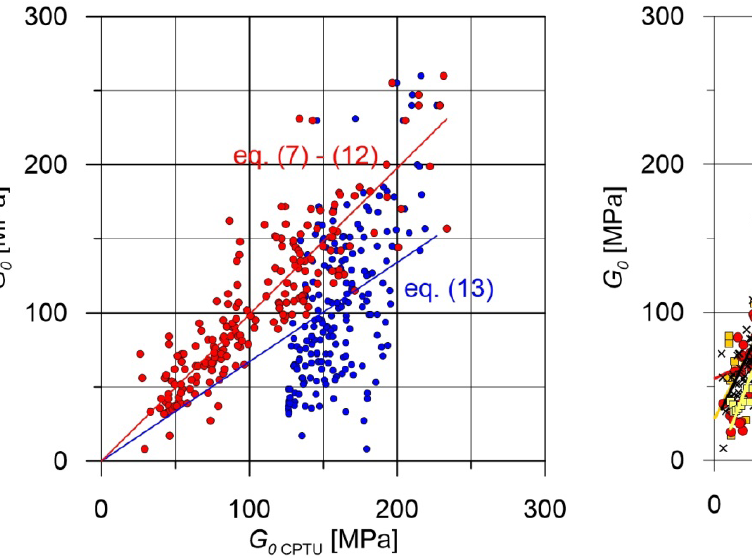
and the preconsolidation Figure 13: The correlation between G 0 stress ( s ’ ) for overconsolidated (OC) (red) and normally p consolidated (NC) soils distinguishing between fine sands (FSa) from Gnojewo test site (dark yellow) and Holmen test site (light yellow) and medium sands (MSa), coarse sands (CSa) and sandy gravels